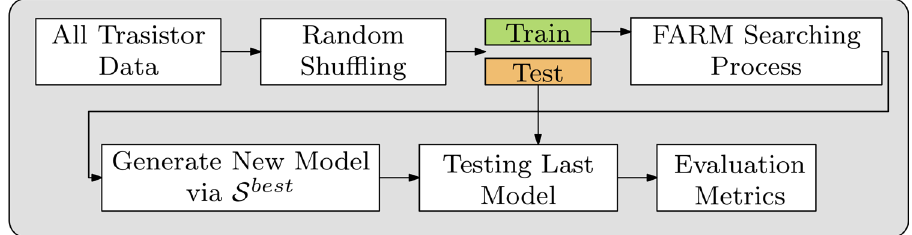
Figure 3. General flow of FARM surrogate construction and validation. Randomly shuffled data is split into training and testing sets. FARM Searching Process (cf. Fig. 2) is executed using the training data. The optimum model parameters are determined, and a new model is generated over the best found parameter set S best . Subsequently, the model performance metrics are evaluated using the testing